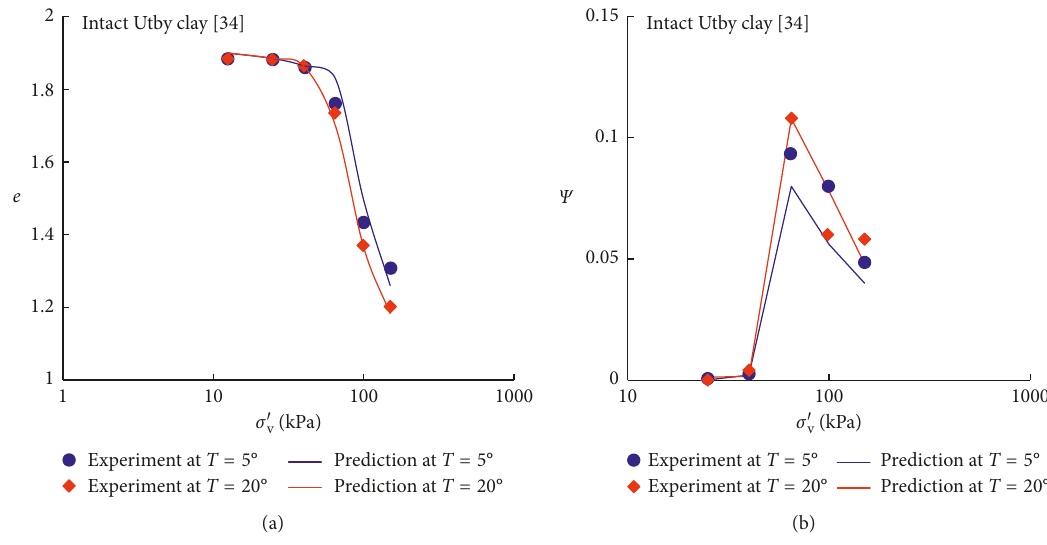
Figure 9: Predictions of the thermal oedometer test on intact Utby clay (depth (b) creep